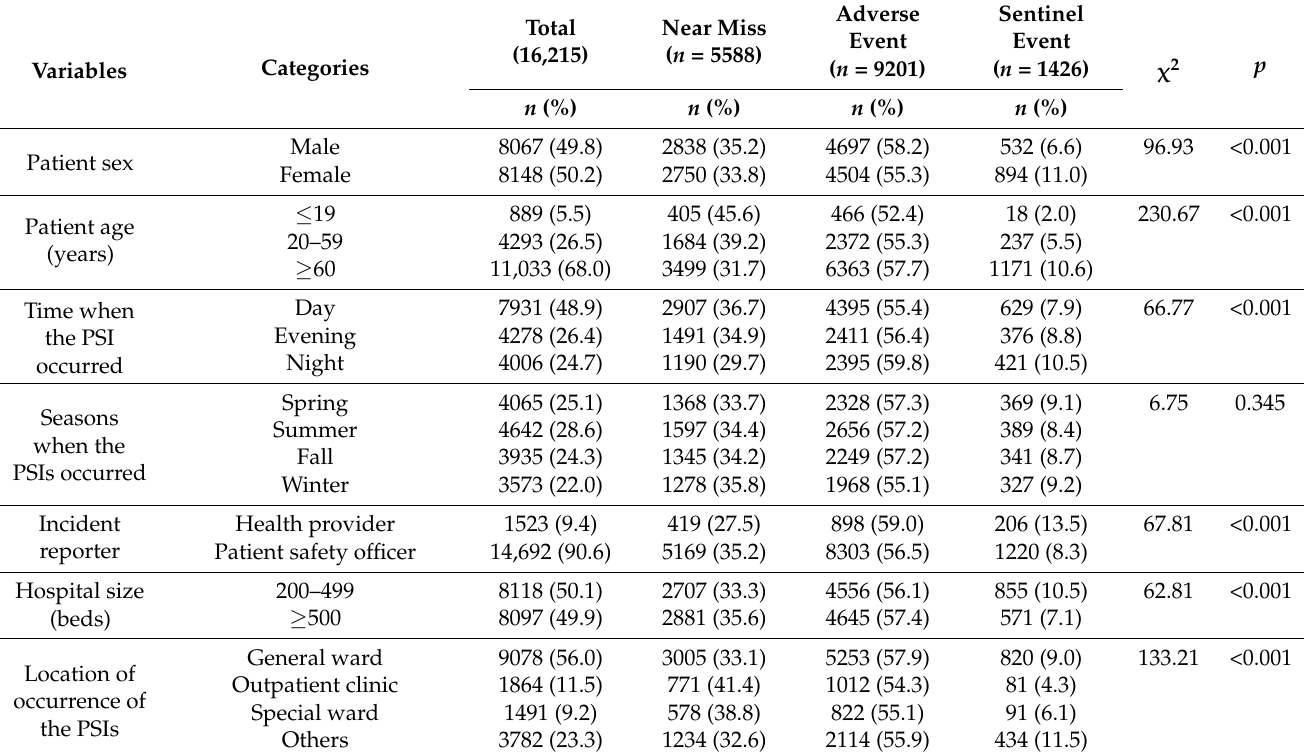
Table 1. Difference in severity of PSIs by research